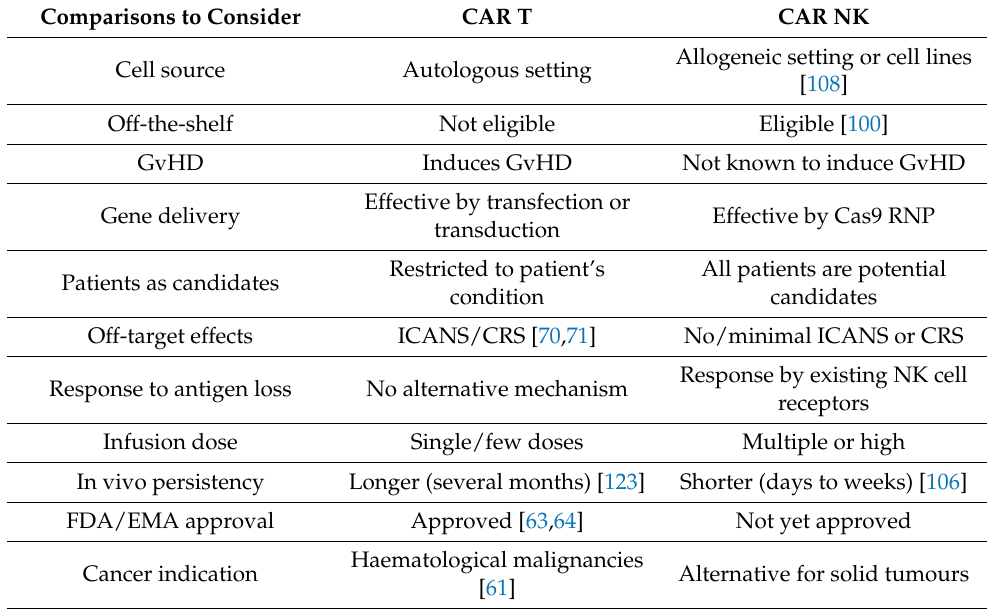
Table 1. Comparisons between CAR T and NK cell